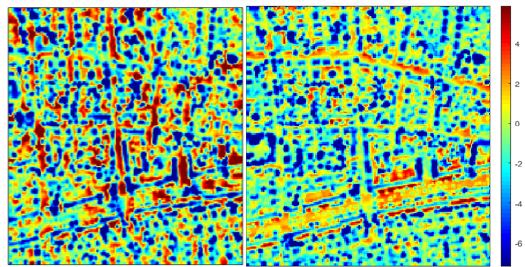
Figure 3. Vertical offsets of TanDEM-X and Cartosat-1 in study areas Figure 7. Height residual map for residential area: TanDEM-X DEM (Left) and Cartosat-1 DEM